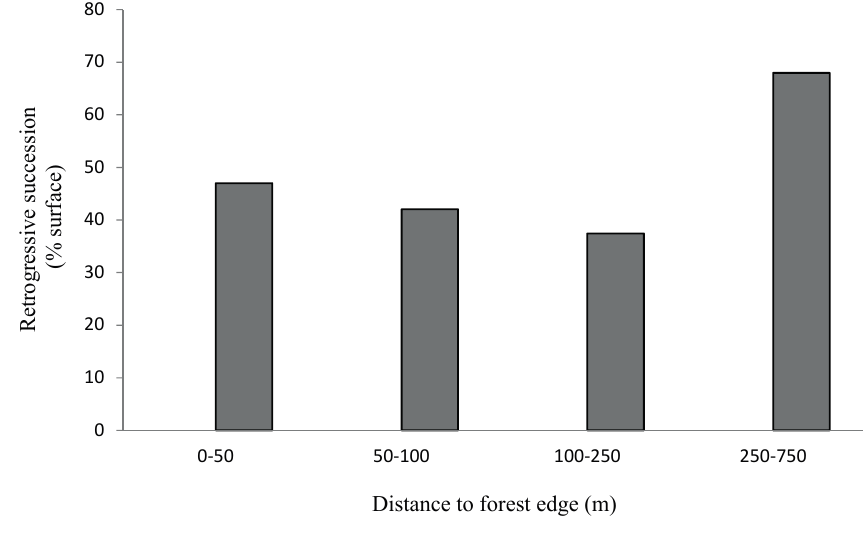
Figure 6. Retrogressive succession to distance from the forest